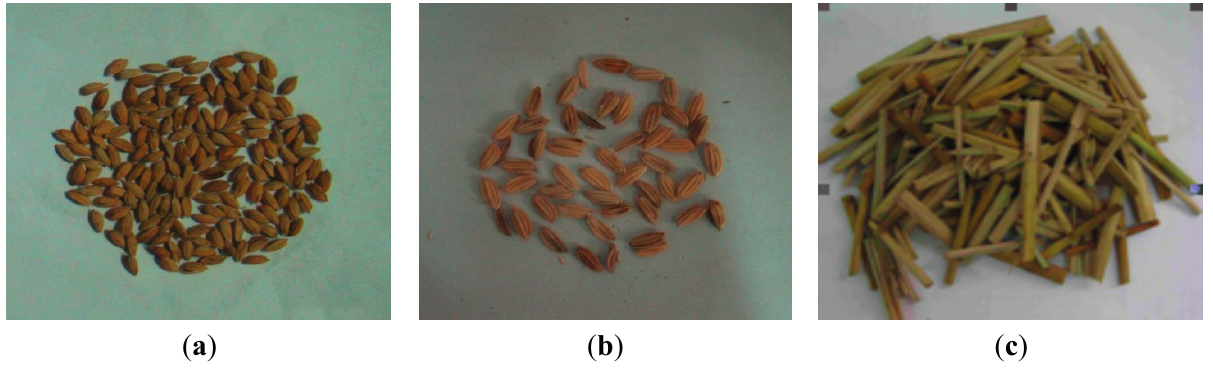
Figure 6. Physical figures of grain and MOG in the mixture ( a ) Full grain; ( b ) blight grain; ( c ) short